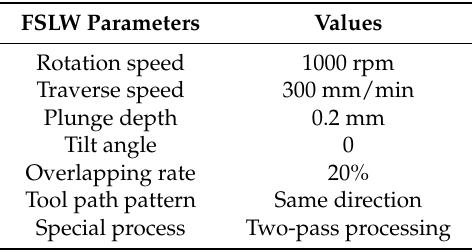
Table 2. FSLW parameters used in this